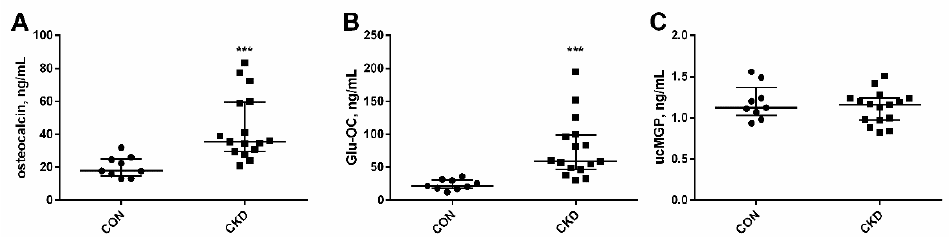
Figure 2. Serum levels of vitamin K ‐ dependent proteins: osteocalcin (A), Glu ‐ OC (B) and ucMGP (C) in rats with chronic kidney disease (CKD) and healthy controls (CON). T he lines correspond to the 25th and 75th percentiles and the median. *** p < 0.001 CON versus CKD rats; Glu ‐ OC—under ‐ carboxylated osteocalcin; ucMGP—undercarboxylated Matrix Gla Protein. Both total osteocalcin and its undercarboxylated form (Glu ‐ OC) in serum were posi ‐ tively correlated with kidney function markers: creatinine and urea concentrations in CKD rats (Figure 3A,B,D,E). The inverse relationship was observed between total oste ‐ ocalcin and creatinine clearance (Figure 3C), whereas circulating Glu ‐ OC was related to PTH concentrations (Figure 3F).